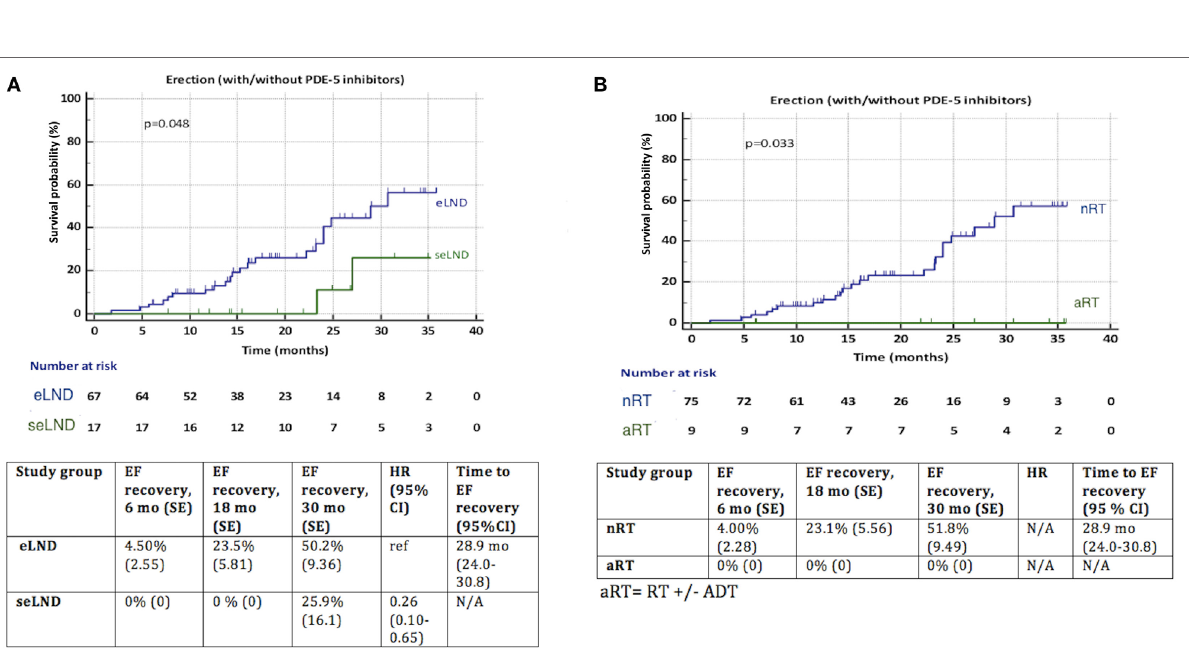
FigUre 6 | (a) Recovery of erectile function (EF) after radical prostatectomy (RP) among patients with extended lymph node dissection (eLND) versus super- extended lymph node dissection (seLND) during surgery. Sensitivity analysis: only patients with good preoperative EF and nerve sparing (NS) surgery. (B) Recovery of EF after RP among patients with adjuvant radiotherapy (aRT) ± androgen deprivation therapy versus no radiotherapy (nRT). Sensitivity analysis: only patients with good preoperative EF and NS surgery. HR, hazard ratio, mo, months, CI, confidence interval, ref, reference, SE, standard